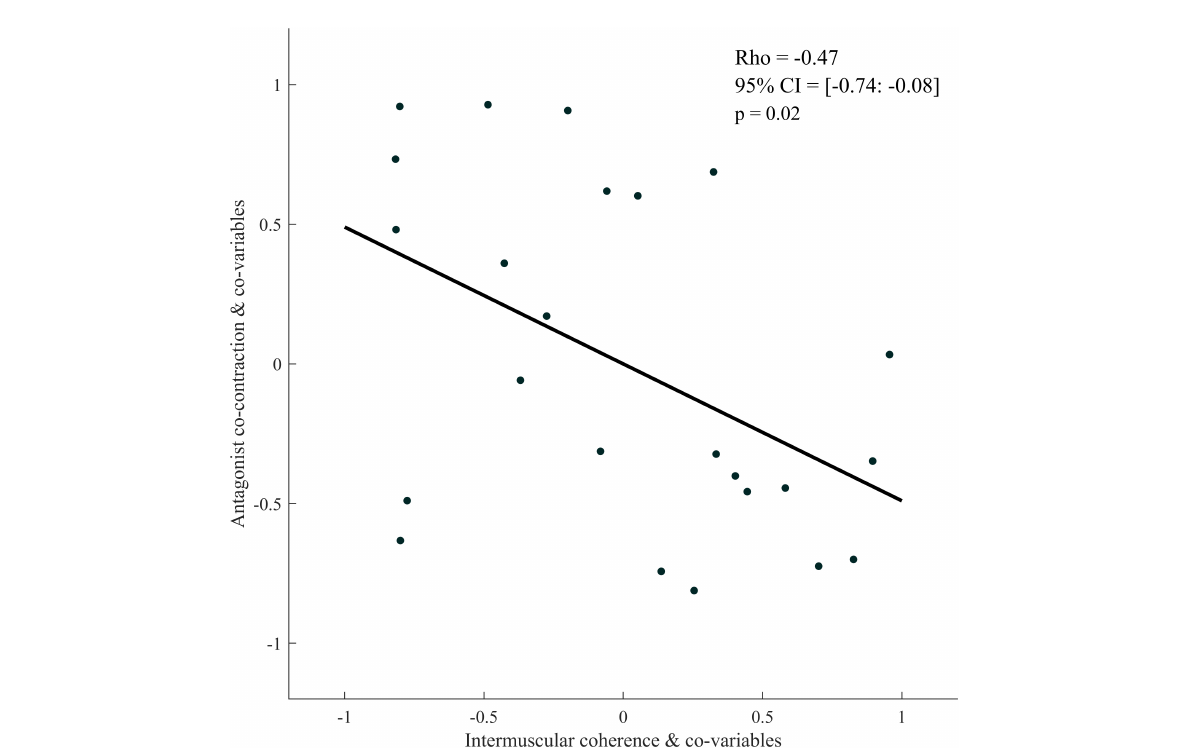
FIGURE7 Partial rank spearman correlation plot between antagonist co-contraction and intermuscular coherence of the Bicep Brachii-Brachioradialis muscle pair for the paretic limb of stroke patients. The data plotted are the residuals of the spearman rank correlation performed between antagonist co-contraction and the covariables and corticomuscular coherence and the covariables.